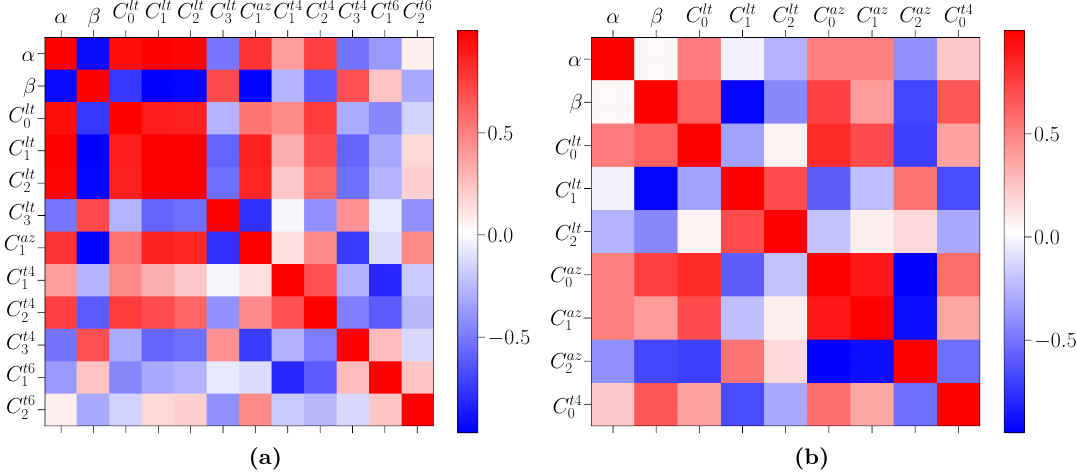
Figure 17. Parameter covariances of the optimal Jacobi polynomial fit to the real (a) and the imaginary (b) component of the unpolarized reduced pseudo-ITD for z/a ≤ 12 with truncation orders { n lt , n az , n t 4 , n t 6 } v = { 4 , 1 , 3 , 2 } v and { n lt , n az , n t 4 , n t 6 } + = { 3 , 3 , 1 , 0 } + , respectively. Entries are p Cov normalized according to Cov Cov . ij / ii jj